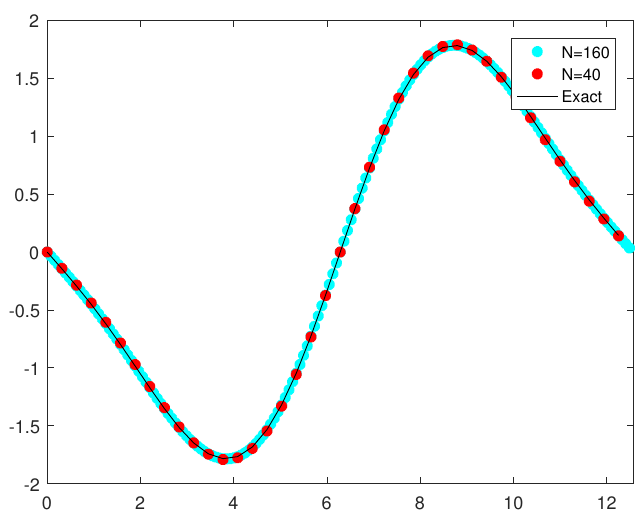
Figure 1. Example 1. The one-dimensional Cahn–Hilliard equation solved by the IIF2 scheme. Time: T = 1 and ∆ t = 0.5 ∆ x . Solid line represents exact solution; red dots represent numerical solution with N = 40; blue dots represent numerical solution with N =